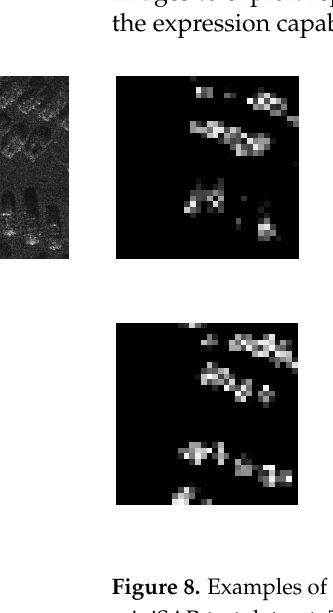
Figure 7. The reconstruction results of the samples in the miniSAR dataset. The first row shows several original miniSAR chips, and the second row shows the corresponding recovered images via the decoder of the proposed method. Each column denotes the original and reconstructed chips pair.